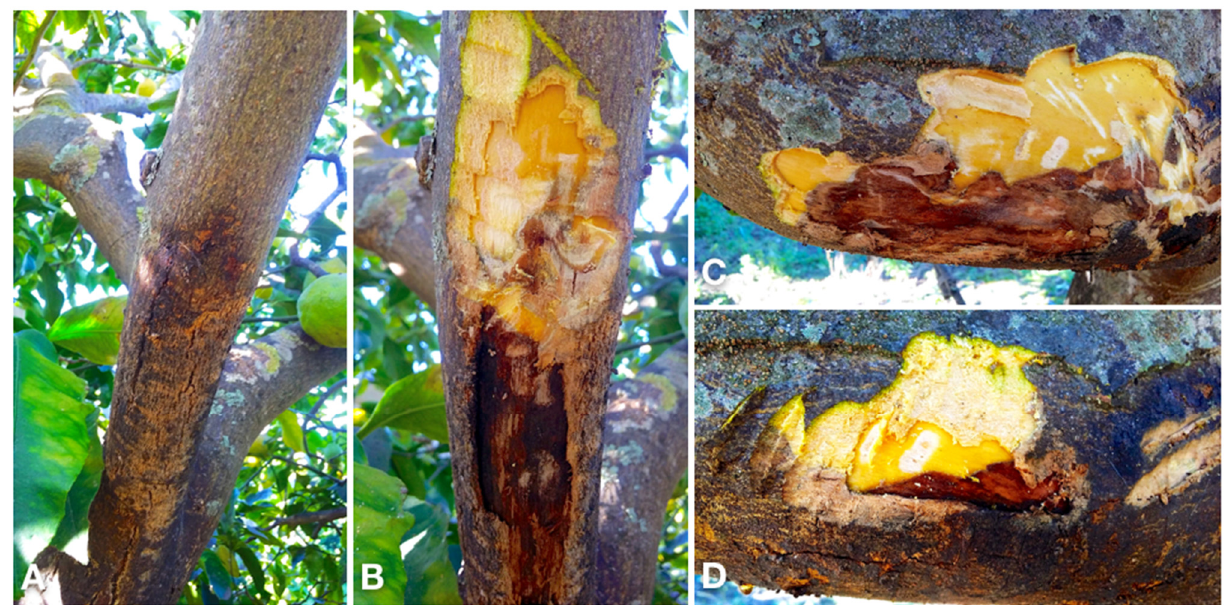
Figure 3. ( A ) Old canker on a secondary branch of lemon tree with longitudinal bark splitting at the base of the branch and the gum exudate in the advancing upward front, indicating the canker is still active; ( B ) the same as ( A ) after peeling the bark to show the dark brown discoloration of the wood beneath the bark; ( C ) typical chocolate brown discoloration of the wood underneath the bark; ( D ) a detail showing the necrotic bark of the canker exuding gum and the typical chocolate brown wood discoloration beneath the bark.